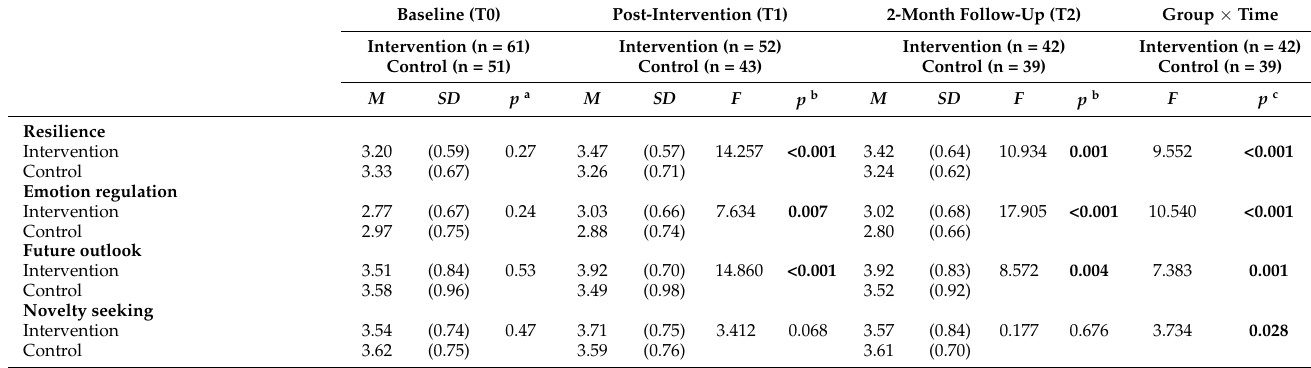
Table 3. Comparison between groups